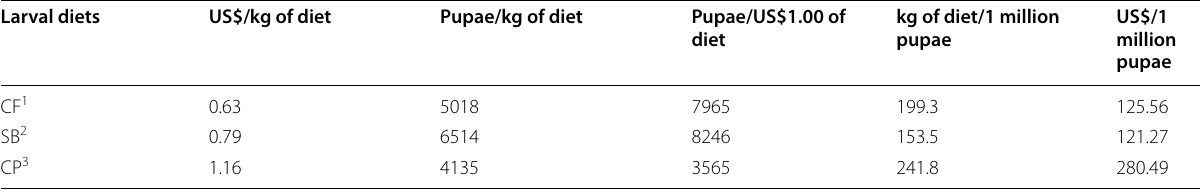
Table 4 Productivity data and costs of the three tested larval diets for Ceratitis capitata